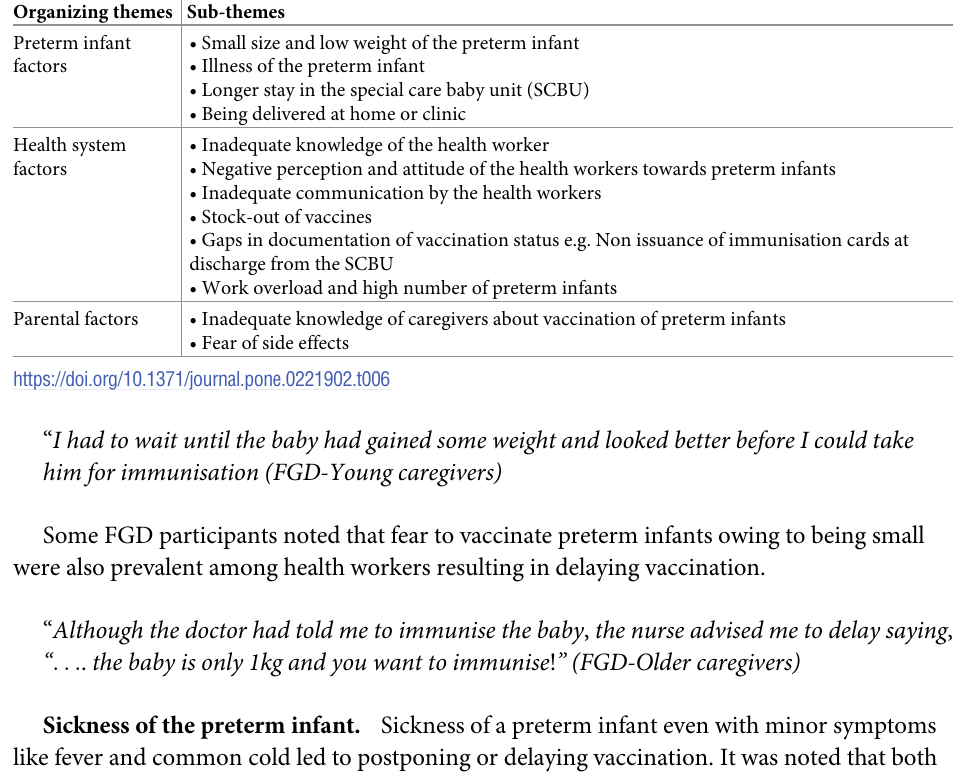
Table 6. Reasons for untimely vaccination of preterm infants aged 6–24 months at Mulago Hospital, Kampala, Uganda. Organizing themes